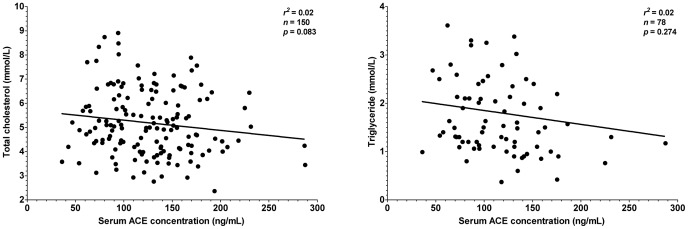
There is no relationship between serum lipid levels and serum ACE concentration.Total cholesterol and triglyceride levels are plotted as a function of the serum ACE concentration (n = 151 patients). Points were fitted by a linear regression to reveal the potential correlation between the plotted parameters. Parameters of the fitting are shown in each graph. Normal rage for total cholesterol is lower than 5.2 mmol/L for triglyceride is lower than 1.7 mmol/L.